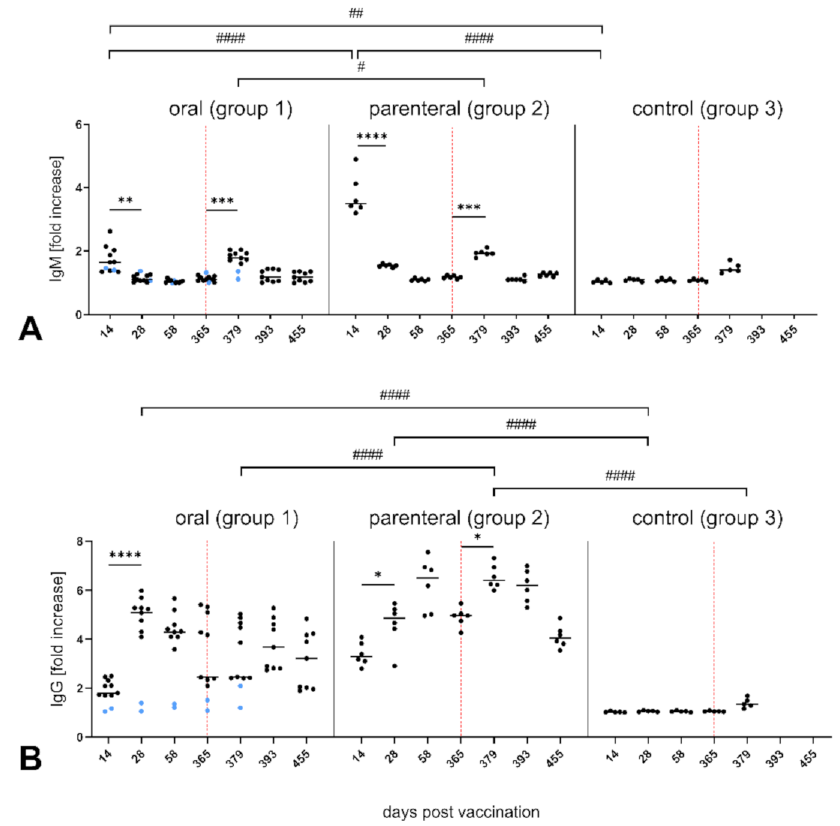
Figure 2. Kinetics of RABV-specific IgM ( A ) and IgG ( B ) in serum of vaccinated and naïve foxes post vaccination and post challenge. Data are expressed as fold change values for individual animals (dots) and as mean (horizontal line) for each sampling time point and group. Seronegative foxes (No ◦ 34 and 41) in the orally vaccinated group are shown in blue. Statistically significant differences between consecutive sampling time points within groups are denoted as follows: * p ≤ 0.01; ** p ≤ 0.005; *** p ≤ 0.001; **** p ≤ 0.0001, while those between groups were denoted by # p ≤ 0.01; ## p ≤ 0.005; #### p ≤ 0.0001. The vertical dotted line indicates the Time Point of challenge (365